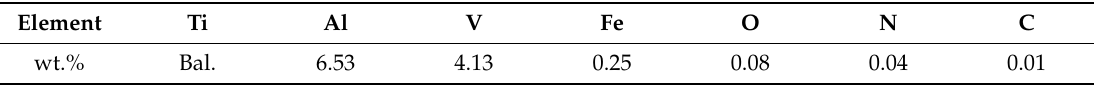
Table 1. Chemical composition and material characteristics of used powder. Element Ti Al V Fe O N C wt.% Bal. 6.53 4.13